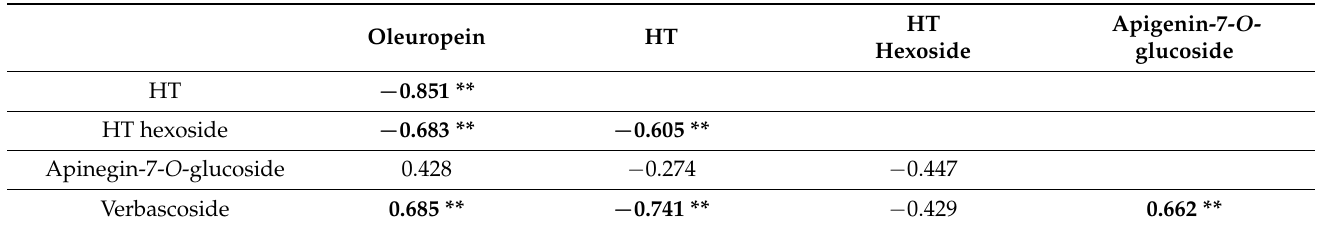
Table 1. Correlation between concentration of phenolic compounds studied in olive leaves.